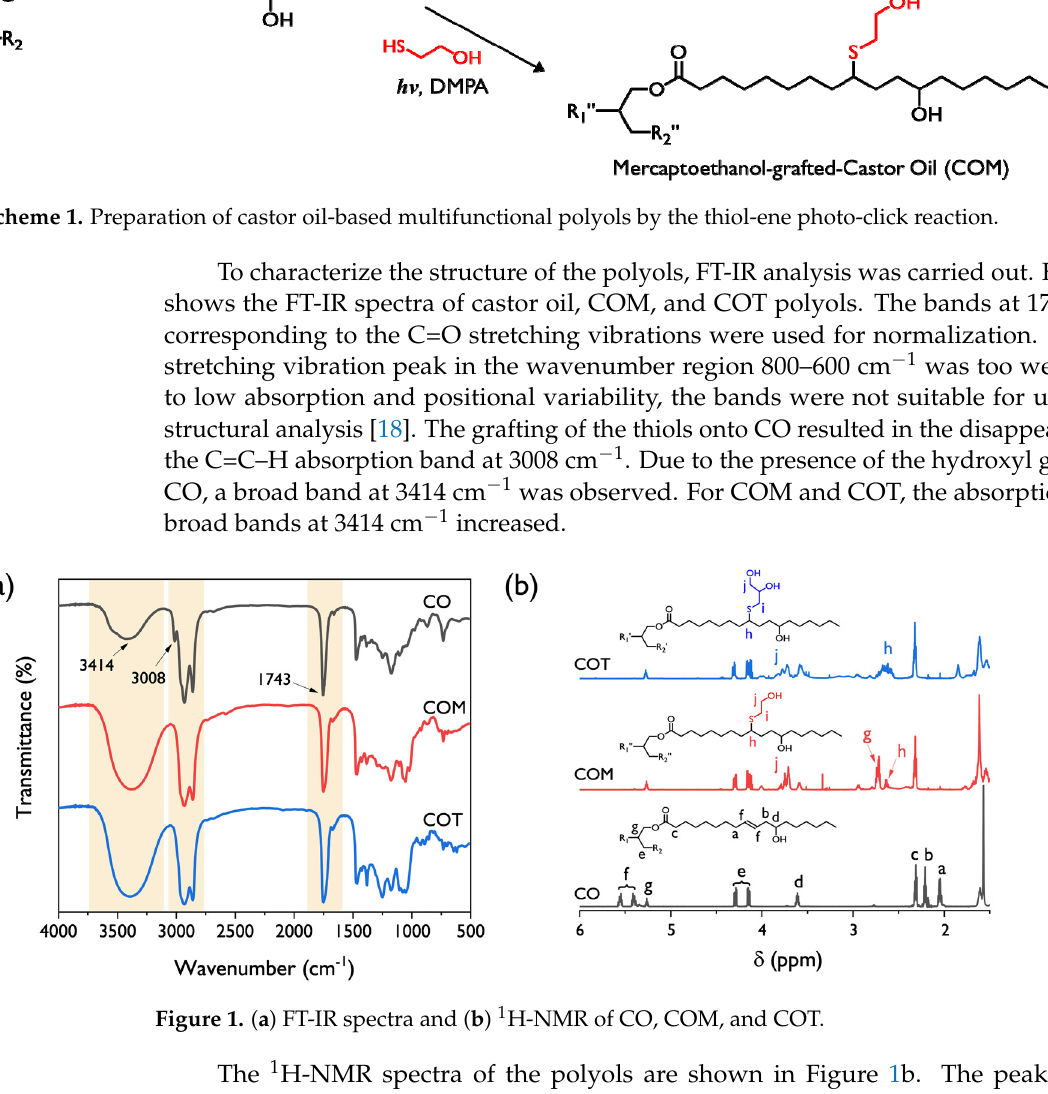
reaction between thiols and castor oil.